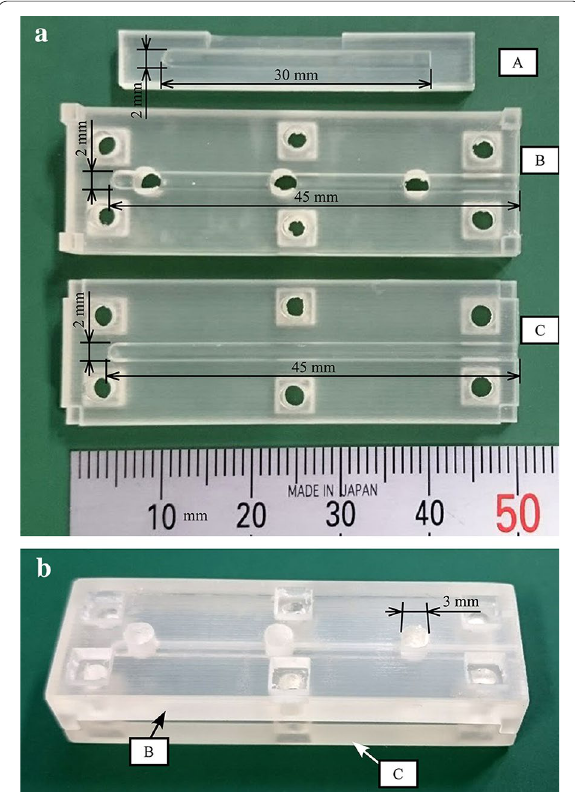
Fig. 3 Molds for the base and cover of the prototype sensor. a Molds (A, B and C). b Molds (B and C)